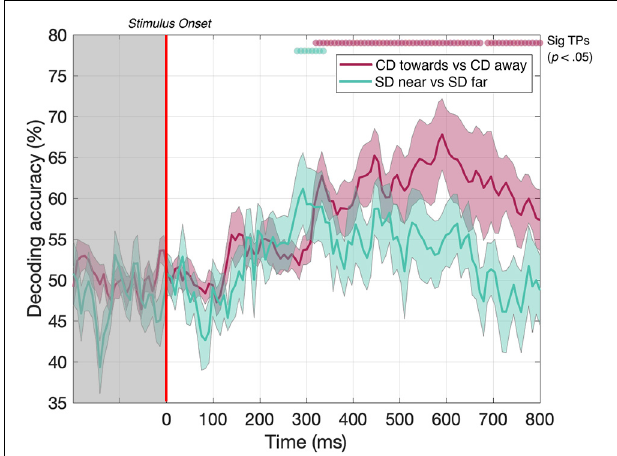
FIGURE 6 | Pairwise decoding accuracy across 125 time points for static disparity (SD) stimuli that are presented either near or far in depth, and for CD stimuli moving either toward or away in depth. Red and green dots indicate time points when the Bonferroni-corrected t -tests were significant ( p < 0.05). Shaded error bars represent ± 1SE of the bootstrapped mean (1000 iterations).